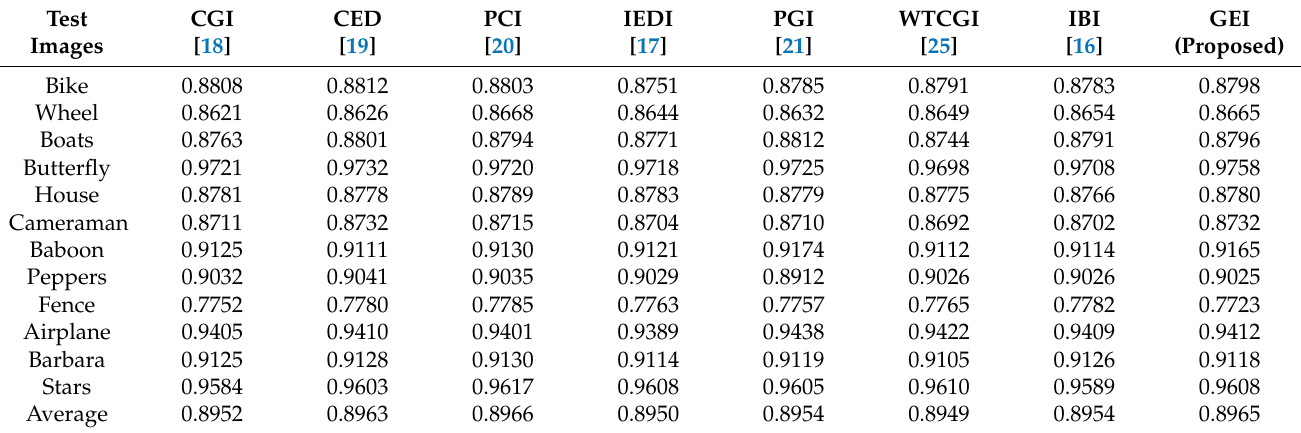
Table 3. A comparison of different interpolation methods with respect to the SSIM (dB).